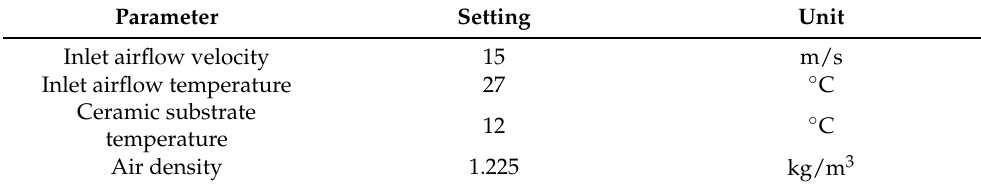
Table 1. Parameter settings. Parameter Setting